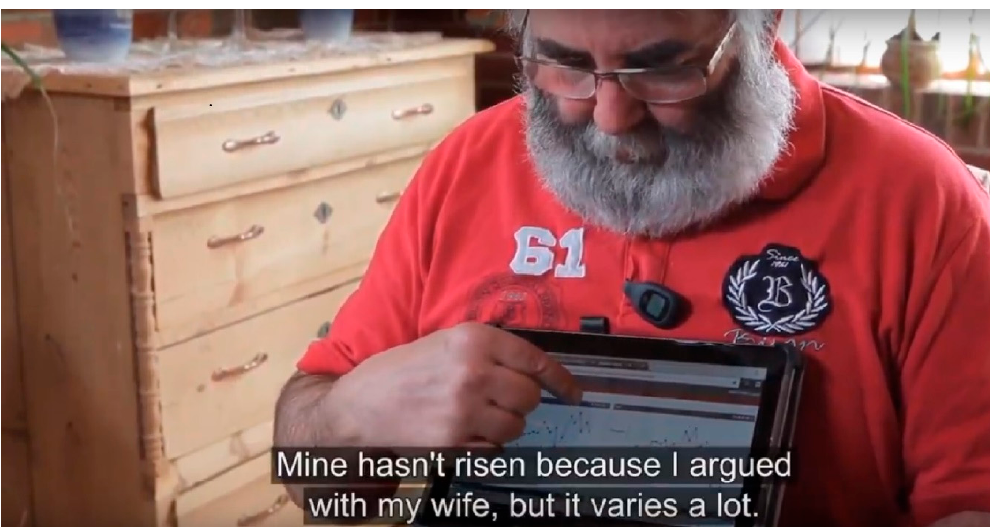
Figure 2. YouTube Video about Teledialog also illustrating the interactive web